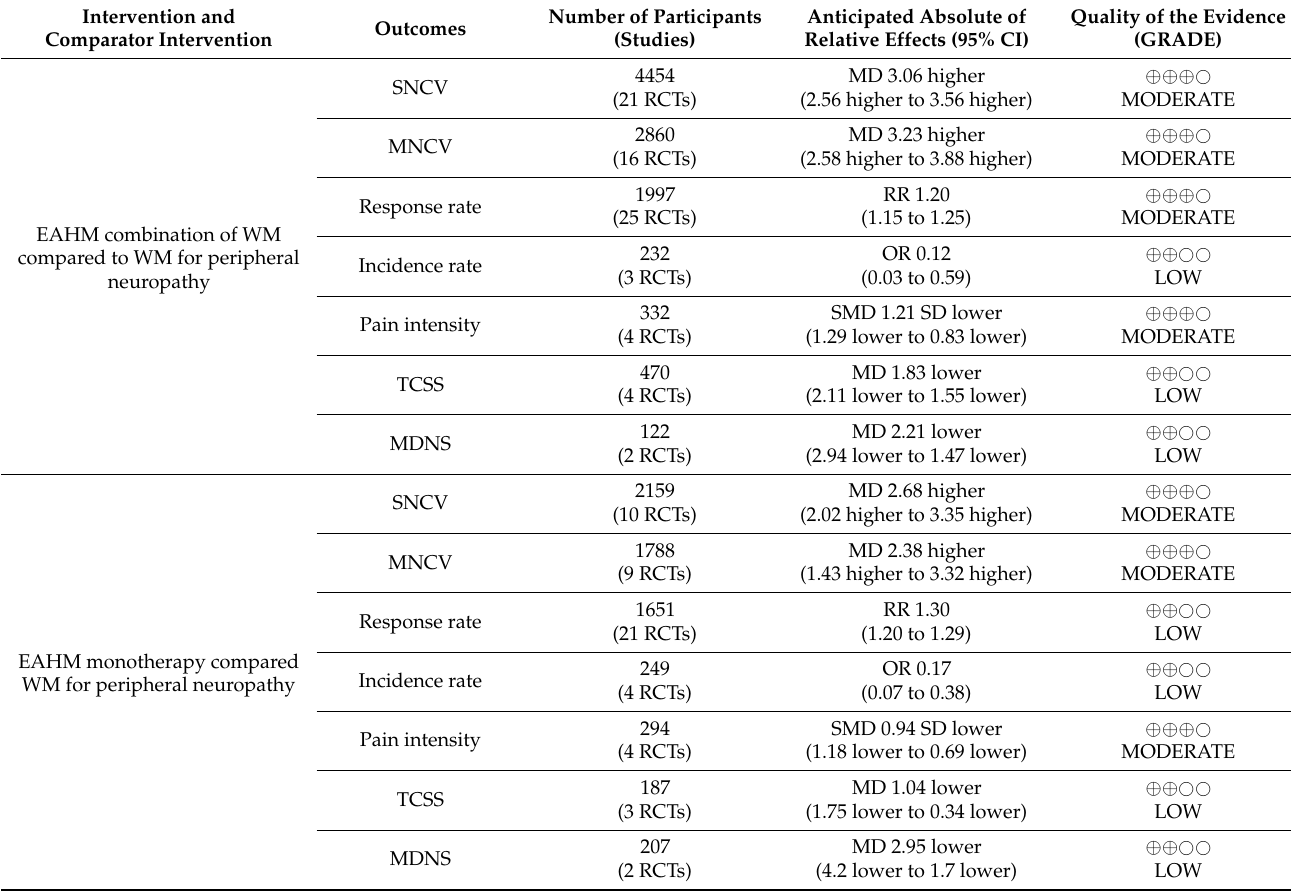
Table 6. Summary of findings for the studies in this